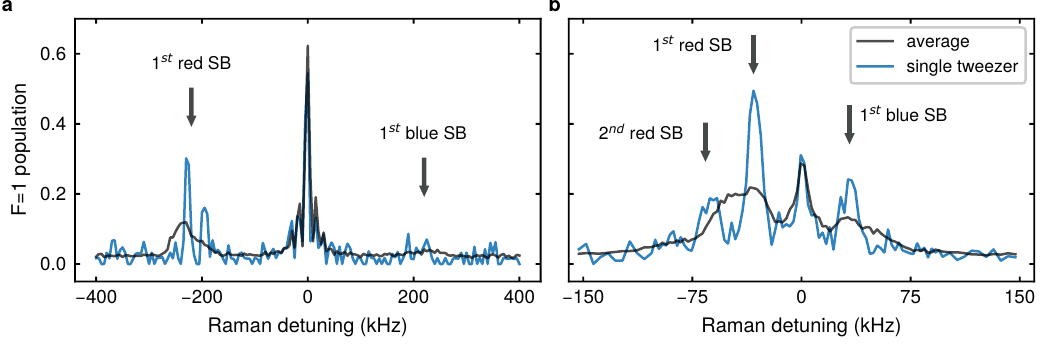
Figure 7: a. Radial spectroscopy of a single tweezer of the array (blue) and the averaged signal over all tweezers (black). The two peaks indicate a slightly elliptic tweezer with different radial trap frequencies. b. Axial spectroscopy for a single tweezer (blue) and averaged over all tweezers (black). For individual traps higher sidebands are also